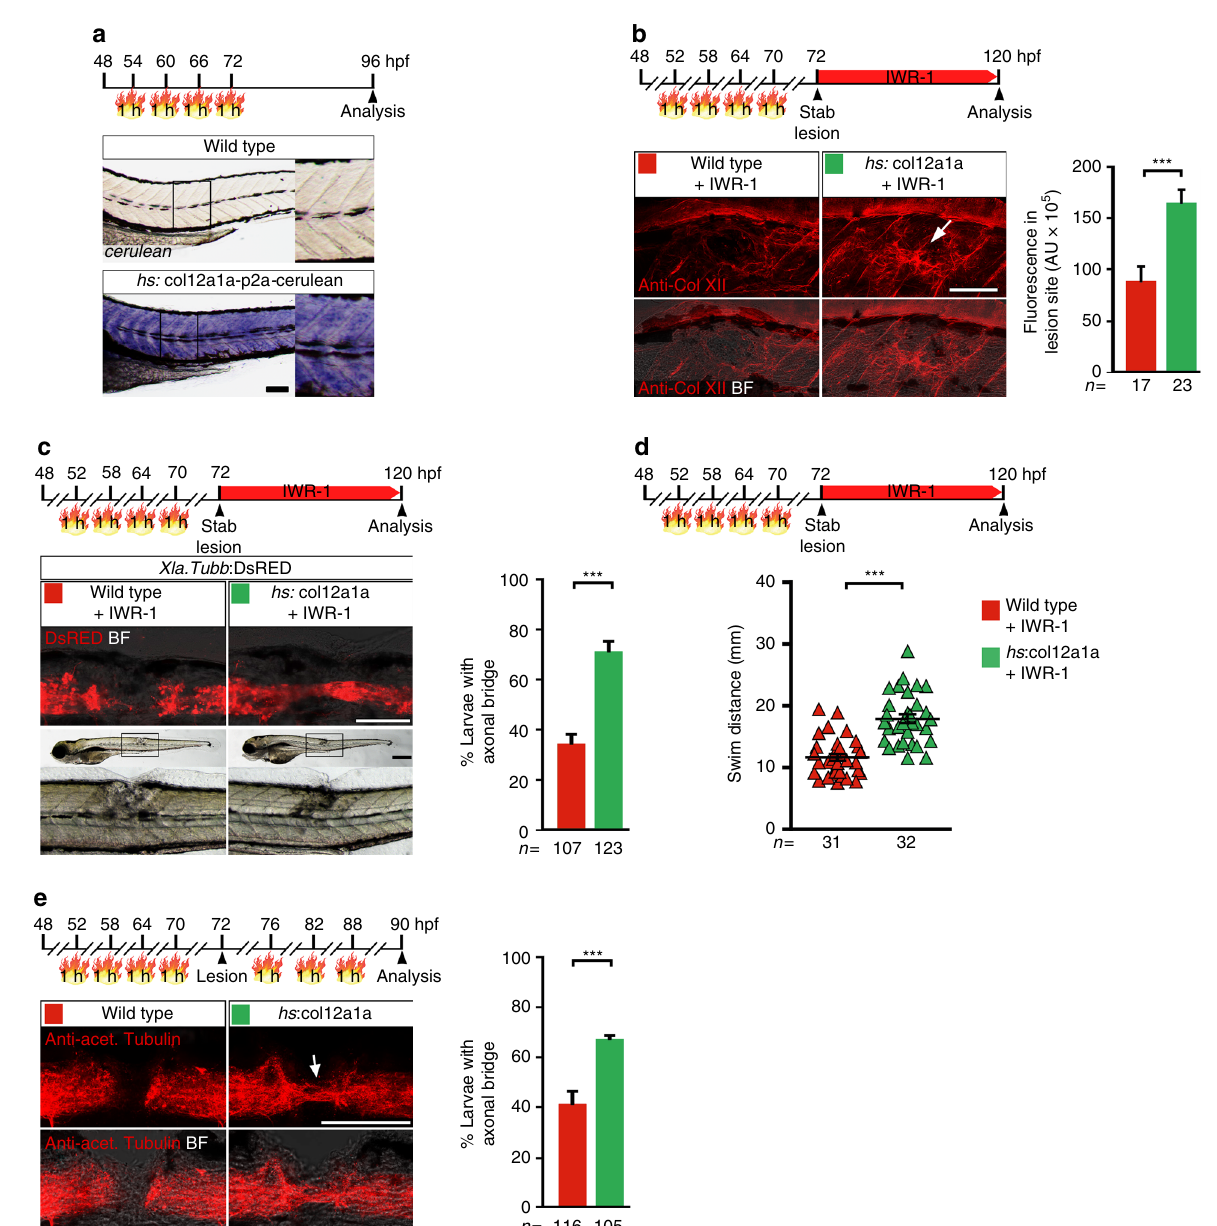
Fig. 7 Overexpression of col12a1a promotes axon regeneration in Wnt/ β -catenin pathway-inhibited and wild type zebra fi sh larvae. a cerulean mRNA is robustly detectable 24 h after the last heat shock in hs :col12a1a-p2a-Cerulean transgenic larvae. b col12a1a overexpression increases anti-Col XII immunoreactivity in the lesion site of Wnt/ β -pathway-inhibited (IWR-1 treatment) hs :col12a1a transgenic larvae ( arrow ; t -test: *** P < 0.001). c col12a1a overexpression rescues axon regeneration in Wnt/ β -catenin pathway-inhibited (IWR-1 treatment) hs :col12a1a transgenic larvae (Fischer ’ s exact test: *** P < 0.001). d col12a1a overexpression improves functional recovery in Wnt/ β -catenin pathway-inhibited (IWR-1 treatment) hs :col12a1a transgenic larvae ( t -test: *** P < 0.001). e col12a1a overexpression is suf fi cient to augment axon regeneration (Fischer ’ s exact test: *** P < 0.001). a – e Views are lateral (dorsal is up , rostral is left ). BF: bright fi eld. Scale bars : 200 µ m c and 100 µ m a – c , e . Error bars indicate